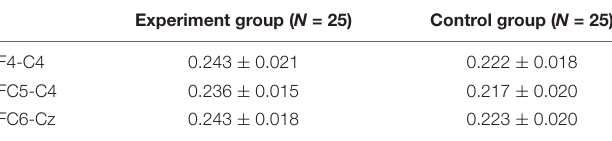
TABLE 4 | The significantly higher wPLI value in the experimental group than that in the control group on beta band (M ± SD). Experiment group ( N =